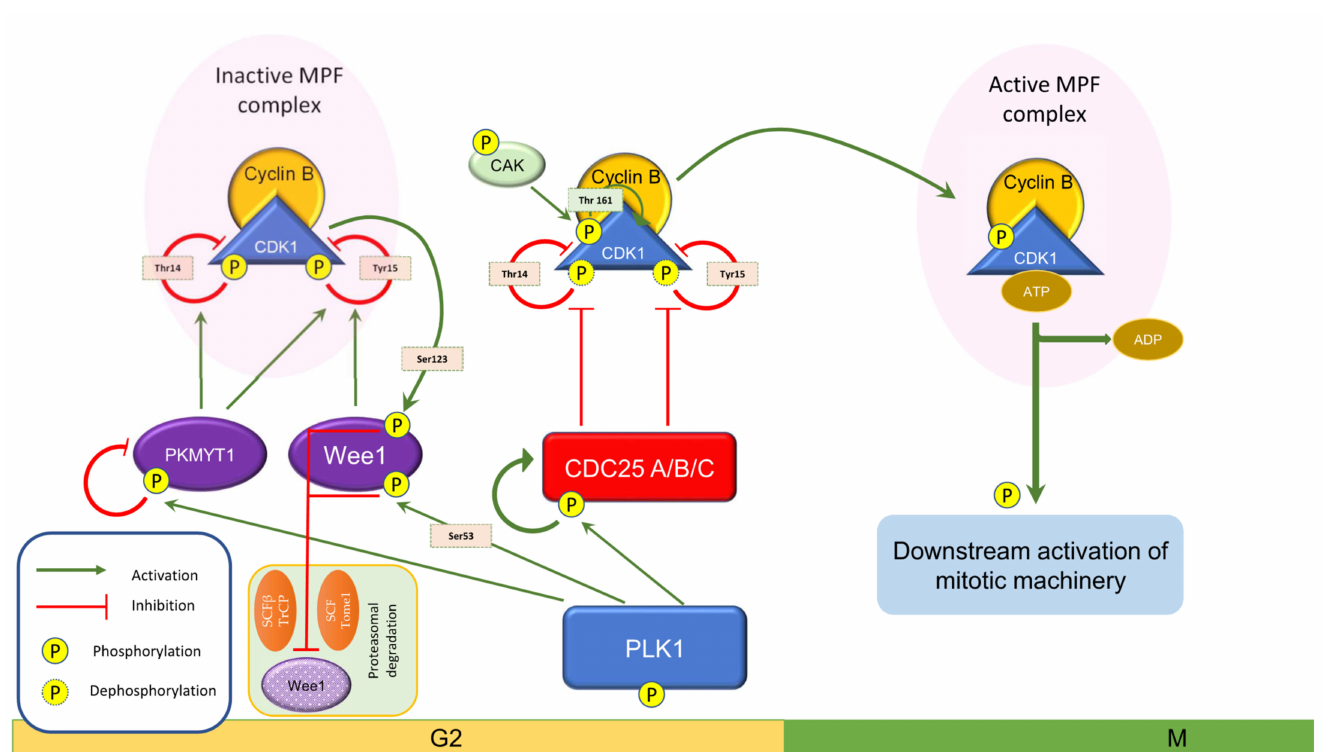
Figure 2. Schematic representation of the components involved in G2/M cell cycle